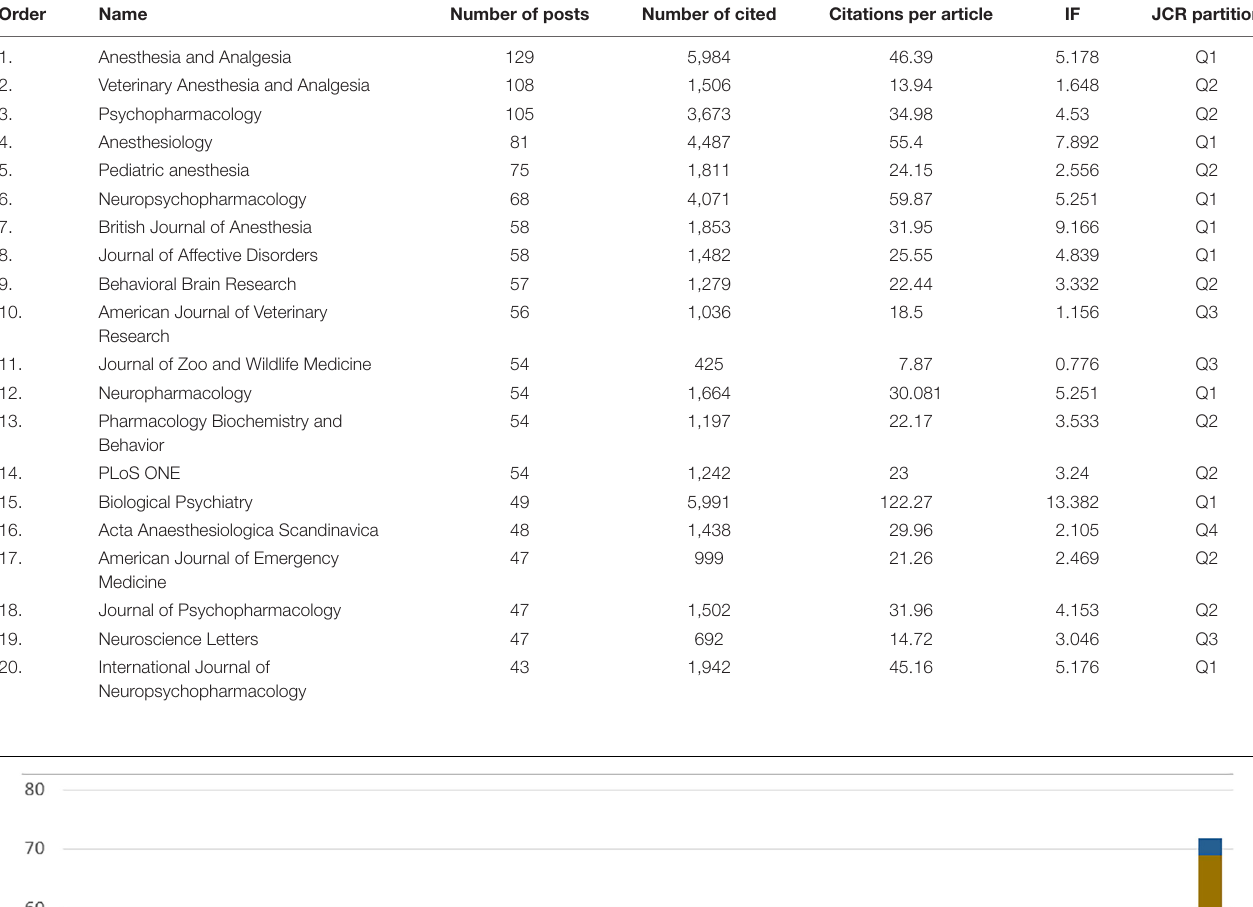
TABLE 5 | Ranking of the top 20 journals by citations.